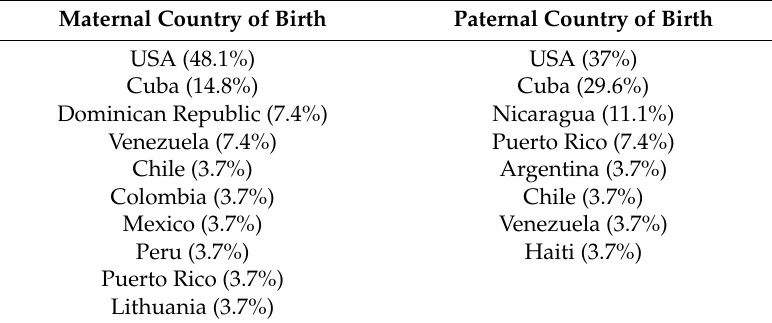
Table 1. Maternal and paternal country of birth in mixed Hispanic sample. 1